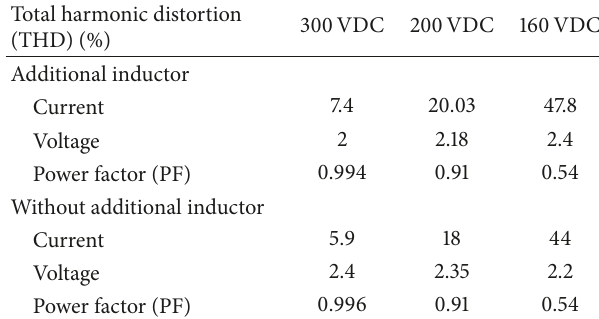
Table 3: THD of the output voltage, current, and PF of the SB 1700E